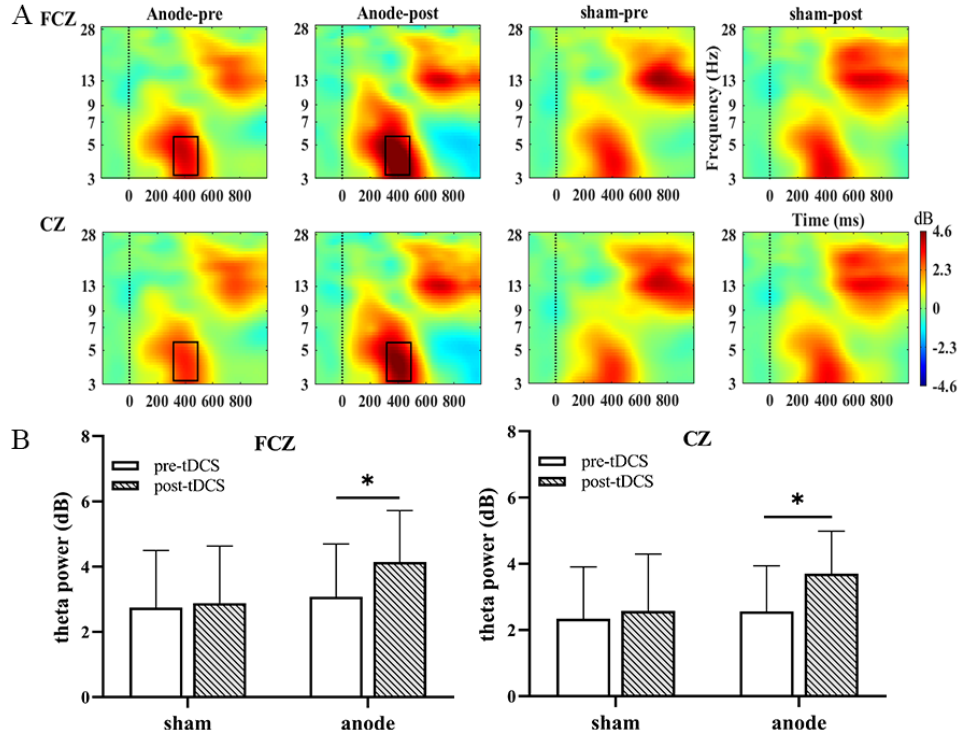
Figure 5. The results obtained from the FCZ and CZ electrodes are shown in ( A ). A significant difference in ERSP is seen between the two conditions (winning and losing) before and after treatment under high-risk conditions based on a paired t test. The black boxes define the time-frequency region of interest where the power increases significantly. In addition, ( B ) shows the theta oscillation active bar graph at two locations [bars indicate the standard error of the mean. * p <0.05]. Table 3. Planned 2 × 2 repeated measure ANOVA on theta oscillation power over time (pre-tDCS,